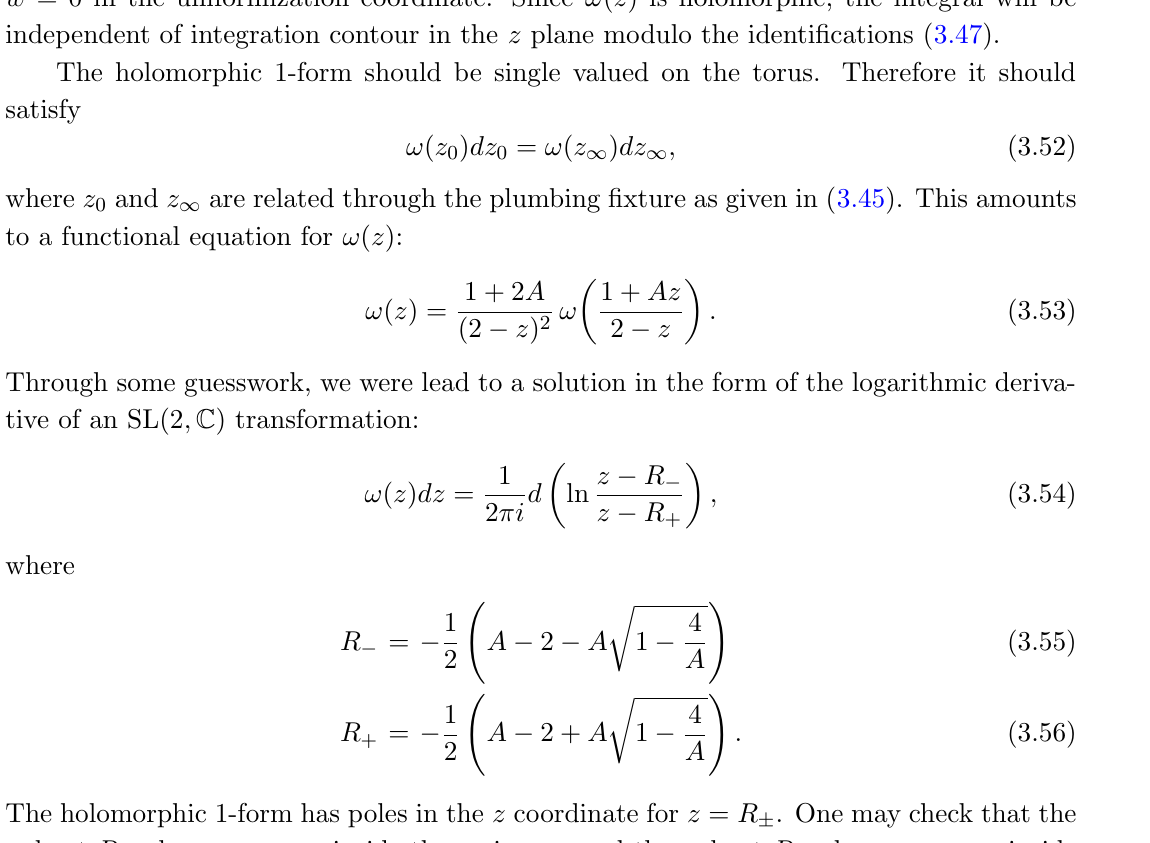
Figure 3 . Picture of the surface state (3.43) in the z -plane. The local coordinate (cid:24) 1 , representing the external state of the tadpole, is mapped to the z -plane just as in the cubic vertex. The inner and outer dashed circles are glued together (with a twist) to create a torus. The dark grey region represents the part of the torus created by the cubic vertex, and the lighter grey region is the part of the torus created by the propagator tube. A choice of A and B cycles on the torus is also shown. The lower limit of the integral has been chosen so that the puncture will be located at w = 0 in the uniformization coordinate. Since ! ( z ) is holomorphic, the integral will